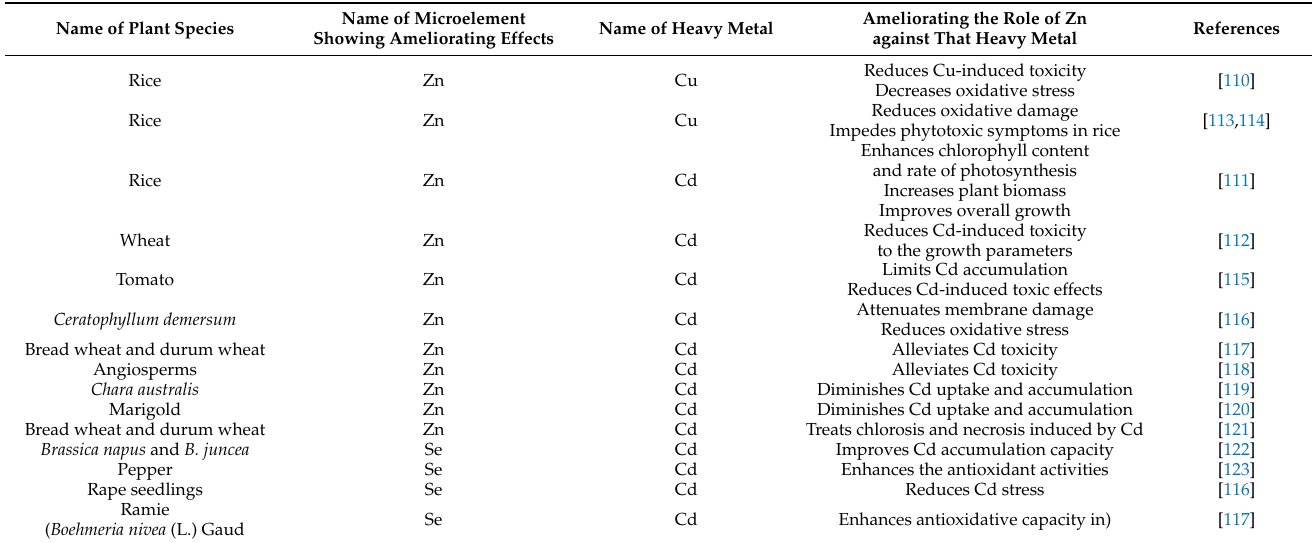
Table 3. Effects of Zn and Se against HMs in different plant